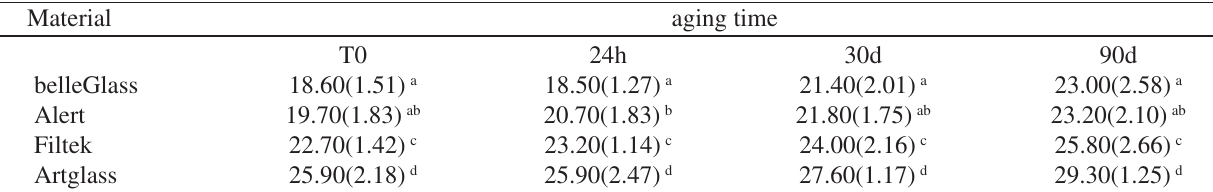
Table 2 . Microhardness values (KHN) of tested materials after different storage time